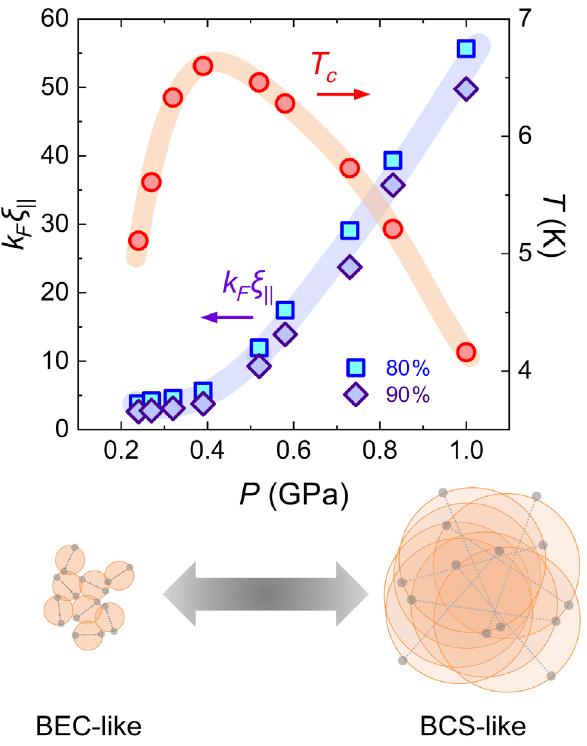
FIG. 5. Pressure dependence of k F ξ k and BEC-BCS crossover. Superconducting transition temperature T c and k F ξ k as a function of temperature, where k F is the Fermi wave number determined by the Hall coefficient [37]. The value of k F ξ k is ∼ 3 at low pressures and increases up to ∼ 50 at 1 GPa with pressure, pointing to a BEC-BCS crossover. Schematics drawn underneath the main panel depict the BEC- and BCS-like pairs on the low- and high-pressure sides.